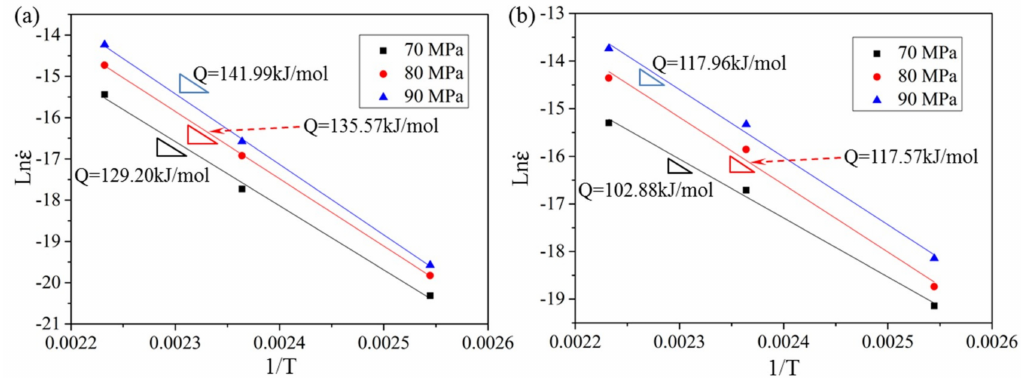
Figure 11. Temperature dependence of the steady creep rate under 70–90 MPa for ( a ) HRRed and ( b ) T5